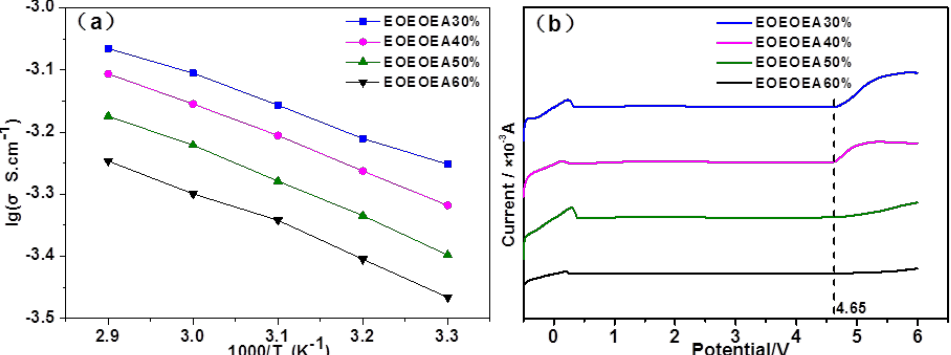
Figure 5. ( a ) Ionic conductivity at 30 °C and ( b ) room-temperature electrochemical windows of different LiBF 4 -EOEOEA GPEs.